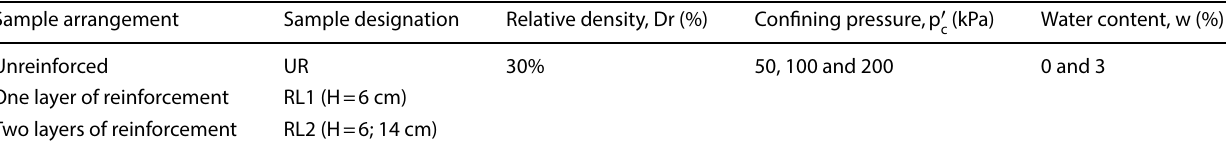
Table 3 Experimental program of consolidated undrained (CU) tests Sample